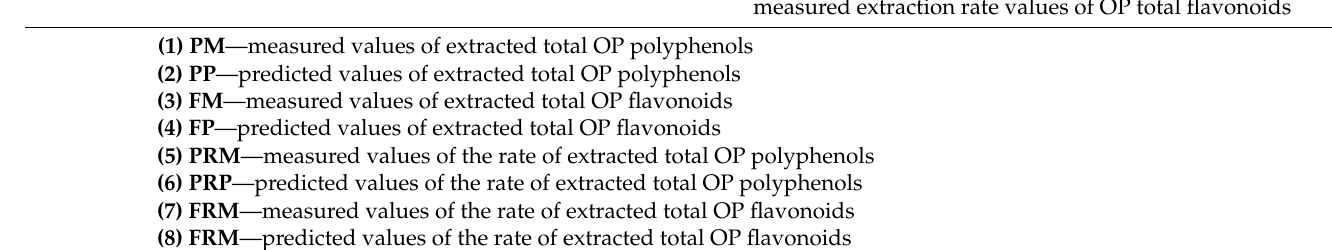
Statistical Significance (2-Tailed) Significance Level =